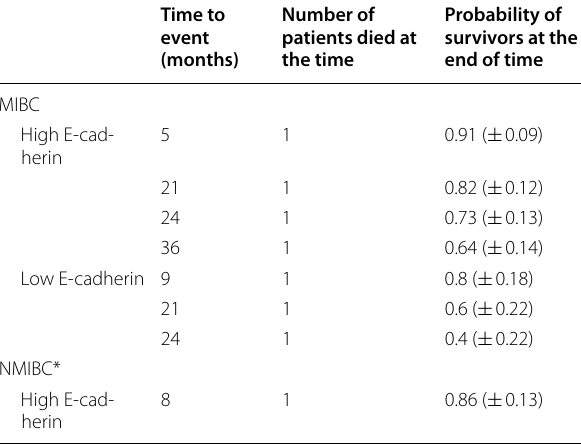
Table 2 Kaplan–Meier survival table of subjects in three years based on muscle invasion and E-cadherin